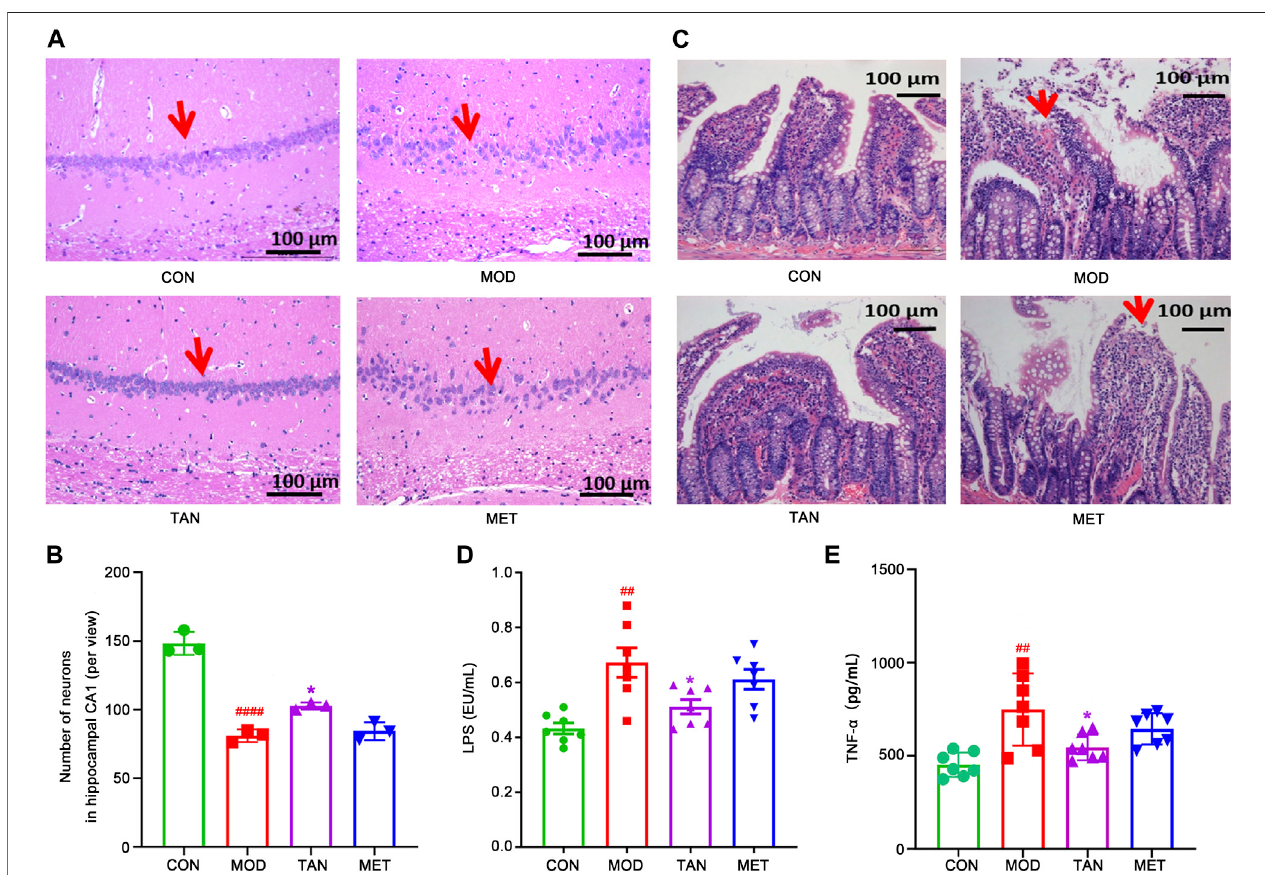
FIGURE 2 | Effect of TAN on histopathologic changes in the rat hippocampal CA1 region and colon tight junction. (A) Representative sections of H&E staining (magni fi cation200×).Redarrowpointstothepackageofneurons. (B) StatisticalanalysisofthenumberofneuronsinthehippocampalCA1area(perview, n =3). #### p < 0.0001vs . CON group and * p < 0.05 vs . MOD group byone-way ANOVA. (C) Representative sections ofH&Estaining(magni fi cation 200×) on colontight-junctionarea in the CON, MOD, and TAN groups. Red arrow represents the damaged villi. TAN treatment reduced plasma levels of LPS (D) and TNF- α (E) in the HFD and STZ- induced diabetic rats, n = 7 rats in each group. # p < 0.05, ## p < 0.01 vs . CON group and * p < 0.05 vs . MOD group by one-way ANOVA analysis. TAN, tanshinone IIA; CON, control; MOD, model; H&E, hematoxylin and eosin; ANOVA, analysis of variance.